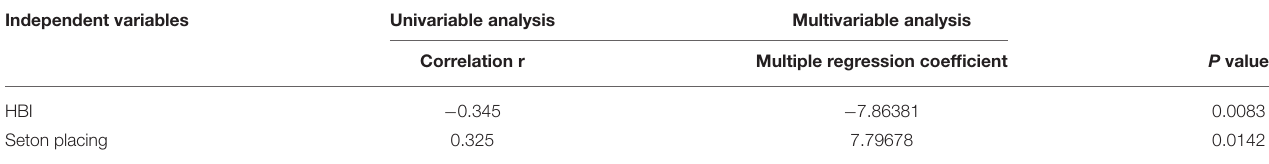
TABLE 3 | Predictors of MCS component of